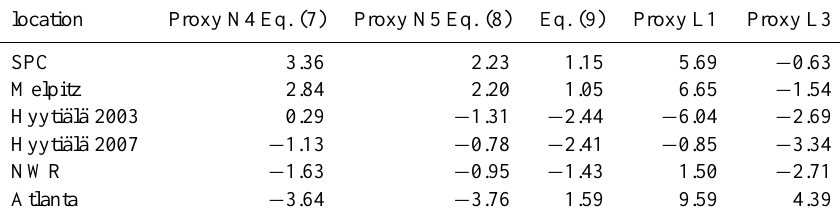
Table A1. Values l i (10 6 m − 3 ) for the proxies derived with the combined dataset. location Proxy N4 Eq.